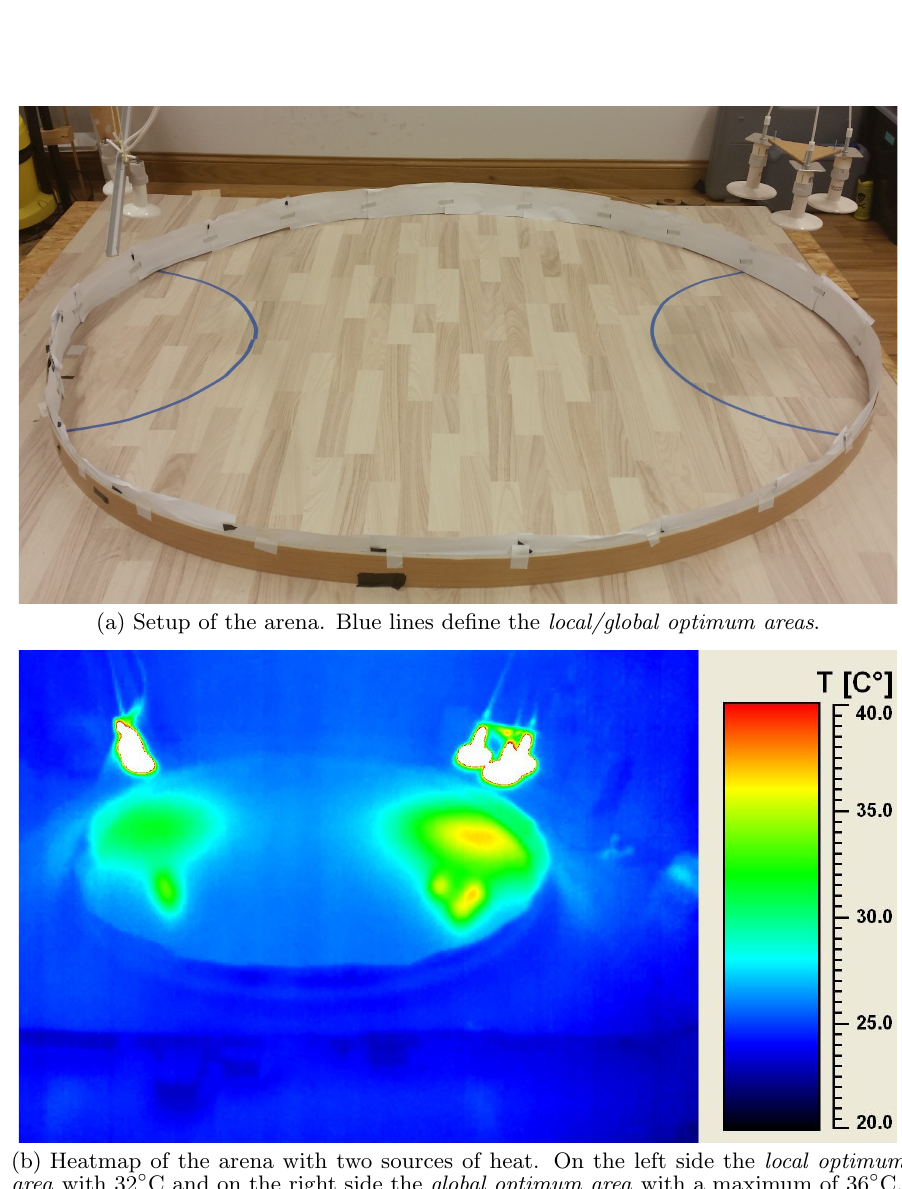
Figure 2: Experimental Setup of the arena and the corresponding